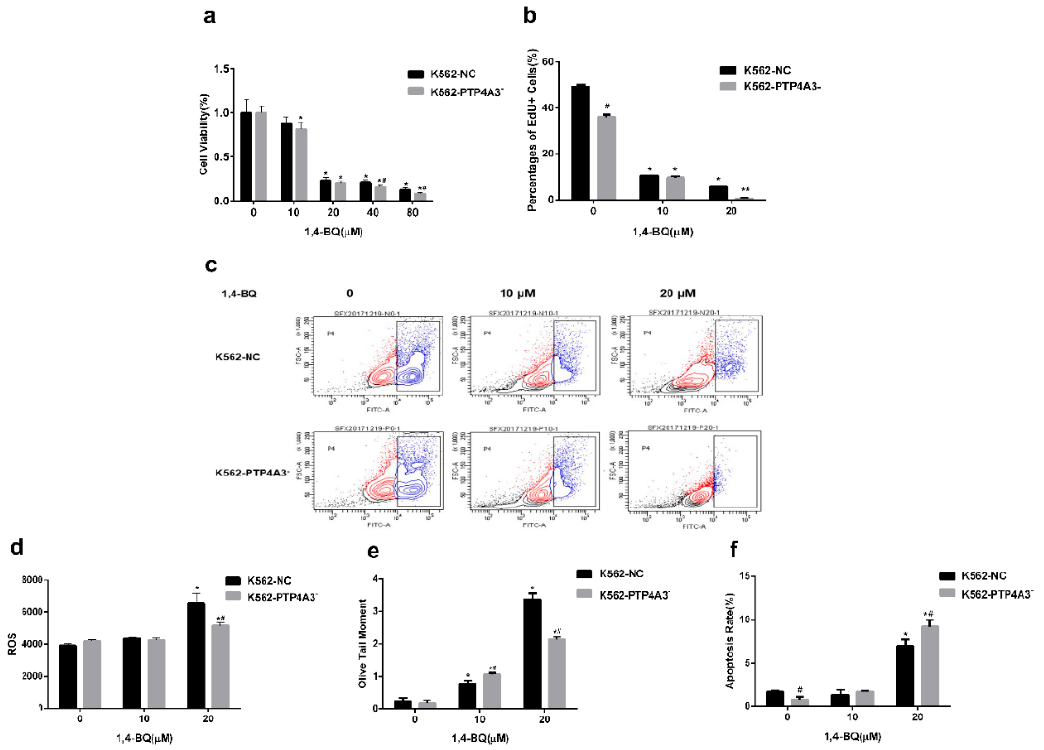
Figure 5. Effects of inhibition of PTP4A3 on the cell proliferation, ROS production, DNA damage and apoptosis after 1,4-BQ treatment. ( a ) The relative cell viability rate was measured by MTT after 1,4-BQ treatment for 24 h. ( b ) The percentage of EdU positive cells was detected by flow cytometer after 1,4-BQ exposure for 24 h. ( c ) The results of EdU recorded from flow cytometry. ( d ) Mean fluorescence intensity of ROS was detected by flow cytometer after 2 h 1,4-BQ treatment. ( e ) DNA damage was tested with comet assay. Olive tail moment was measured to evaluate the DNA damage. ( f ) The percentage of apoptotic cells was tested by flow cytometer after treated with 1.4-BQ for 24 h.*: p < 0.05, compared with 0 µ M group; #: p < 0.05, compared with K562-NC cells at the same concentration of 1,4-BQ. EdU is a thymine analogue which can replace the thymine in DNA replication. EdU is commonly used to investigate the cell DNA replication activity. After exposure to 10 µ M or 20 µ M 1,4-BQ for 24 h, − At the concentration of 20 µ M, the DNA replication activity of K562-PTP4A3 cells was remarkably lower than K562-NC cells (Figure